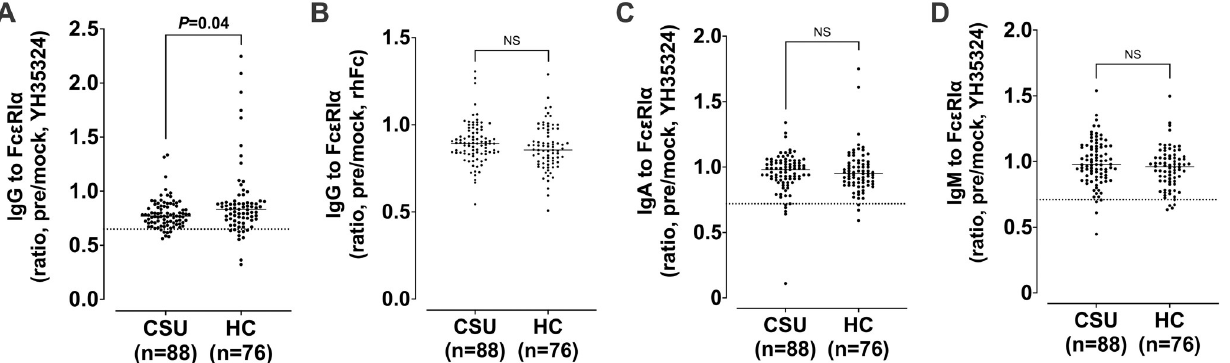
Fig 1. Comparison of serum IgG, IgA, and IgM autoantibodies to Fc ε RI α between patients with chronic spontaneous urticaria (CSU) and healthy controls (HCs). The results were presented by the IgG ratio of YH35324-pretreated to mock-treated values (A), the IgG ratio of rhFc-pretreated to mock- treated value (B), the IgA ratio of YH35324-pretreated to mock-treated value (C) and the IgM ratio of YH35324-pretreated to mock-treated value (D). Horizontal lines and dotted lines show median values and cutoff values of each autoantibody to Fc ε RI α respectively. P values were evaluated by Mann- Whitney test. rhFc, recombinant human Fc; NS, no statistical significance.